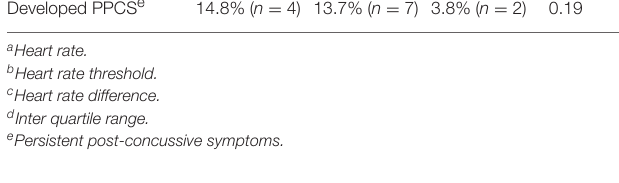
FIGURE 1 | Receiver Operating Characteristics (ROC) curve for 1 HR and Persistent Post-Concussive Symptoms (PPCS) for Rest Group and Placebo Group combined ( n = 78). An ROC analysis of the placebo and rest group showing the ability of 1 HR to predict PPCS. Area under the curve is 0.81. At the 1 HR of < 50 bpm to declare PPCS, sensitivity = 73% and 1-specificity =